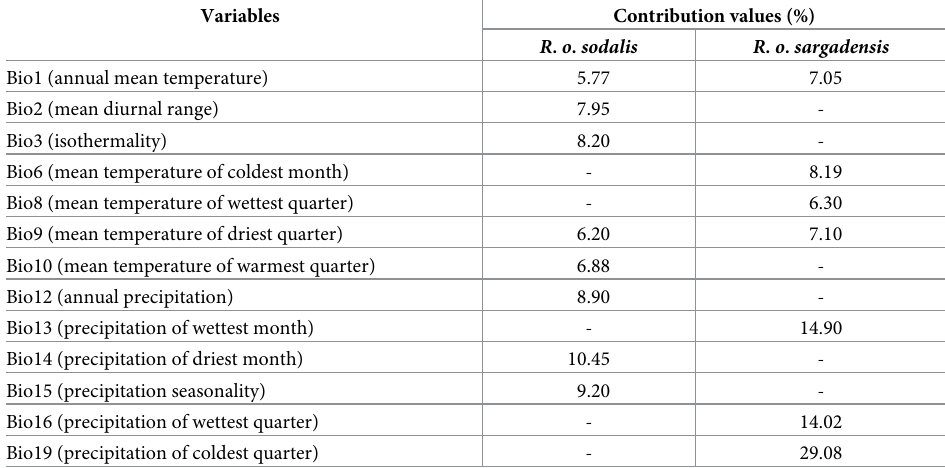
Table 1. Bioclimatic variables included in the MAXENT distribution models and relevant contributed layers for the great gerbil ( Rhombomys opimus )